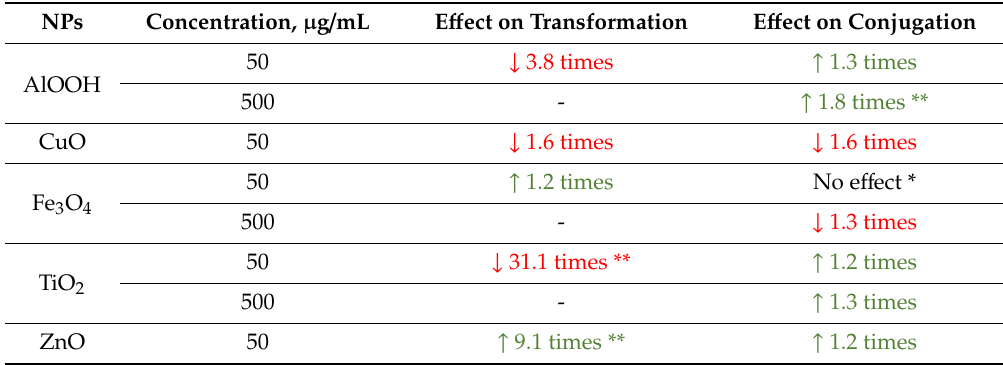
Table 1. The e ff ects of MONPs on antibiotic resistance genes transfer calculated as a ratio between experimental and control colony-forming units (CFU) number.